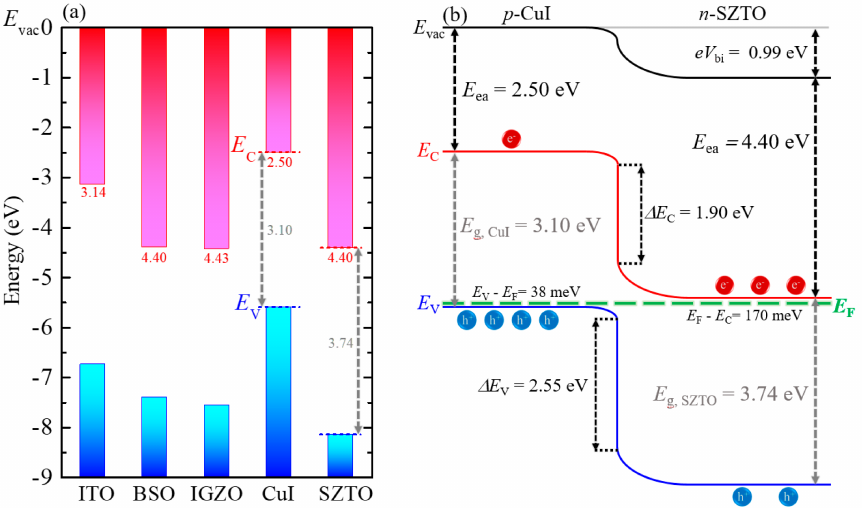
Figure 5. ( a ) Energy band alignment of several wide bandgap materials, including ITO, BSO, IGZO, CuI, and SZTO. The band energies of those materials are aligned at the vacuum energy level E vac = 0. ( b ) A proposed energy band diagram of the annealed CuI (140 nm)/SZTO diode based on the Anderson heterojunction diode model, exhibiting the type-II band alignment.